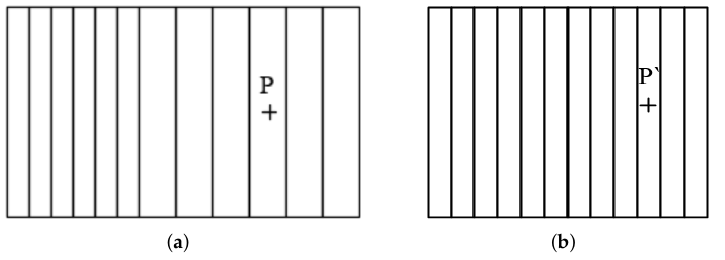
Figure 6. Illustration of the traditional line-time normalization method: ( a ) inner CCD image before traditional line-time normalization and ( b ) inner CCD image after traditional line-time